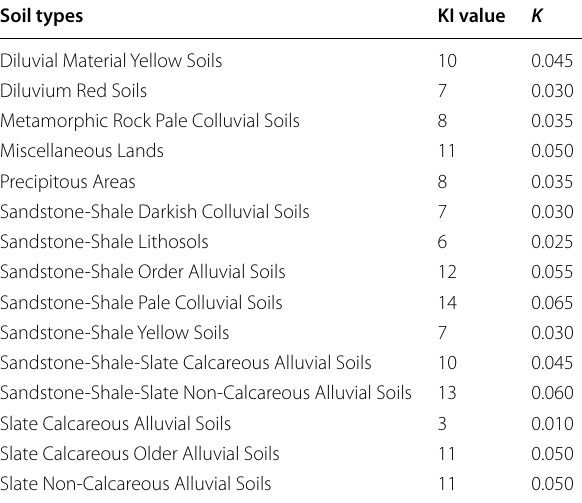
Table 1 K value obtained from KI value based on Taiwanese soil types (adapted from (SWCB